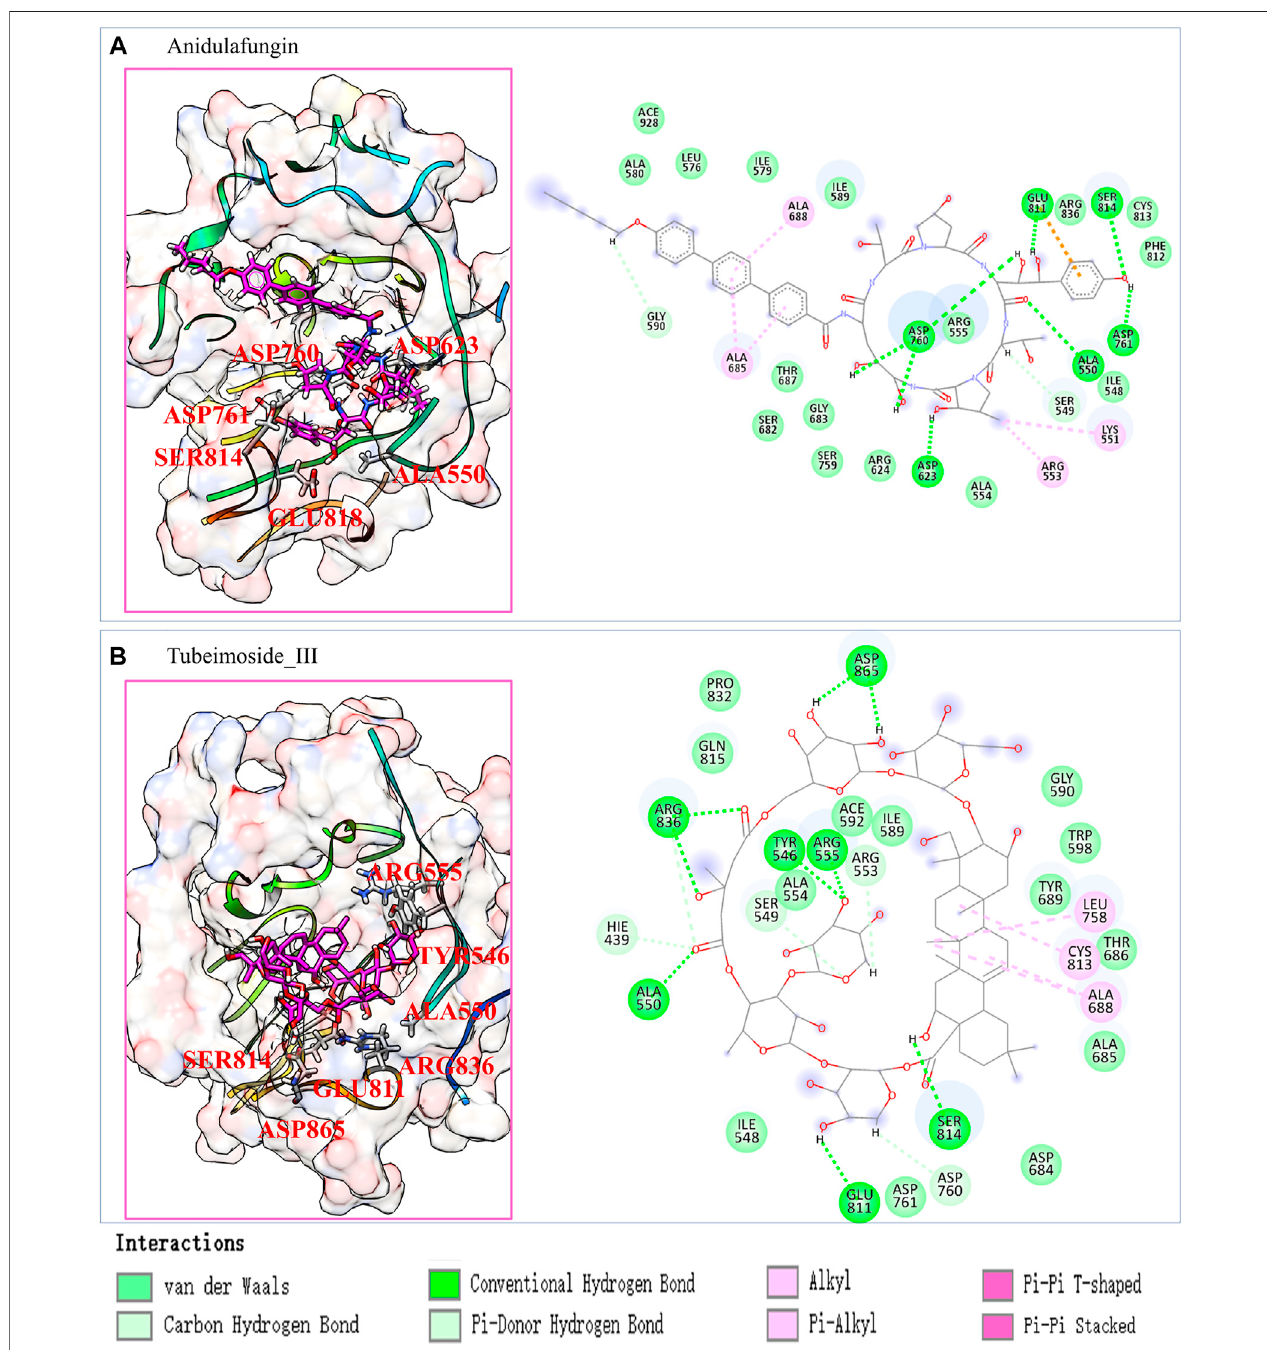
FIGURE 3 | The predicted Anidulafungin and Tubeimoside_III interact with the RdRp pocket. (A) the last frame of RdRp pocket-Anidulafungin complexes from 100 ns MD simulation and its 2D interaction plot. (B) the last frame of RdRp pocket-Tubeimoside_III complexes from 100 ns MD simulation, and its 2D interaction plot.